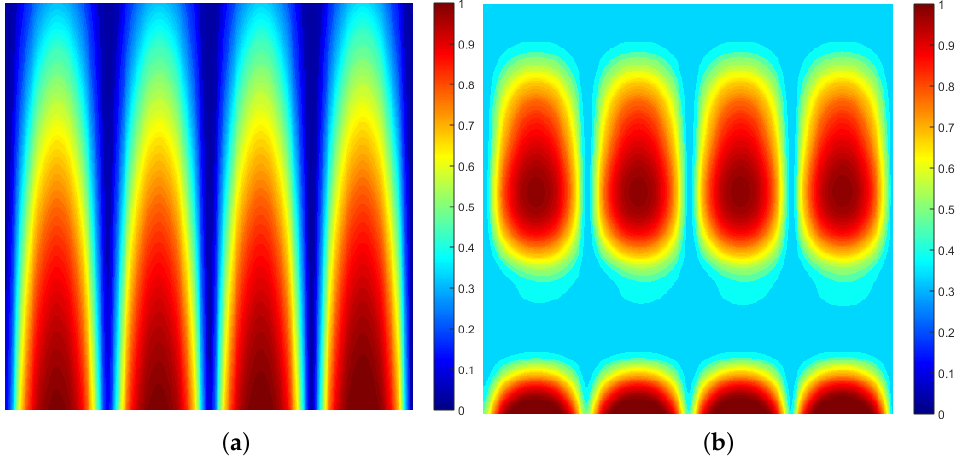
Figure 8. Examples of two solutions of the quantum shutter problem for the Klein–Gordon equation— Equation (73). In both cases, the horizontal axis and the vertical axis are of space x and time t , respectively, where ( 0,0 ) is the lower left-hand corner of the map. ( a ) Space-time map of the function | u ( x , t ) | 2 , x ∈ [ 0,1 ] , t ∈ [ 0 + ,10/ k ] where u ( x , t ) is given by Equation (48) for the Green’s function given by Equation (74) for k = 4 π ; ( b ) space-time map of the function | u ( x , t ) | 2 , x ∈ [ 0,1 ] , t ∈ [ 0 + ,100/ k ] where u ( x , t ) is given by Equation (48) for the Green’s function given by Equation (74) for k = 4 π